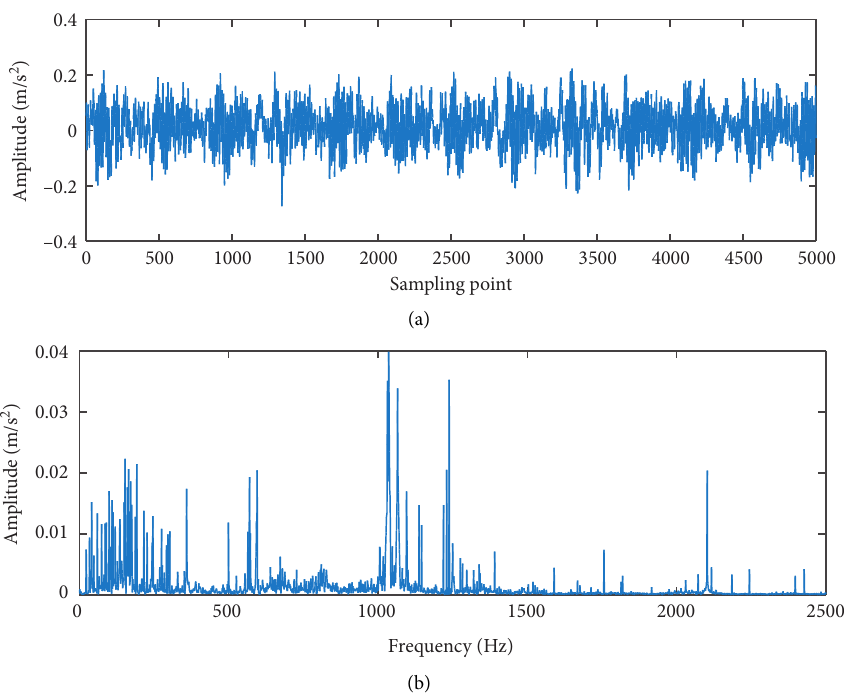
Figure 5: Vibration signal and its spectrum. (a) Time-domain waveform of vibration signal and (b) spectrum of the vibration signal.